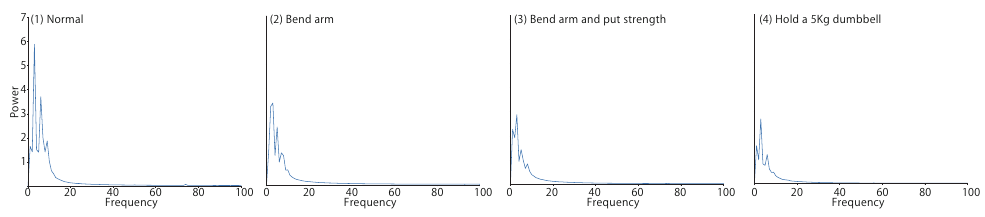
Figure 5. Average FFT power spectrum in four